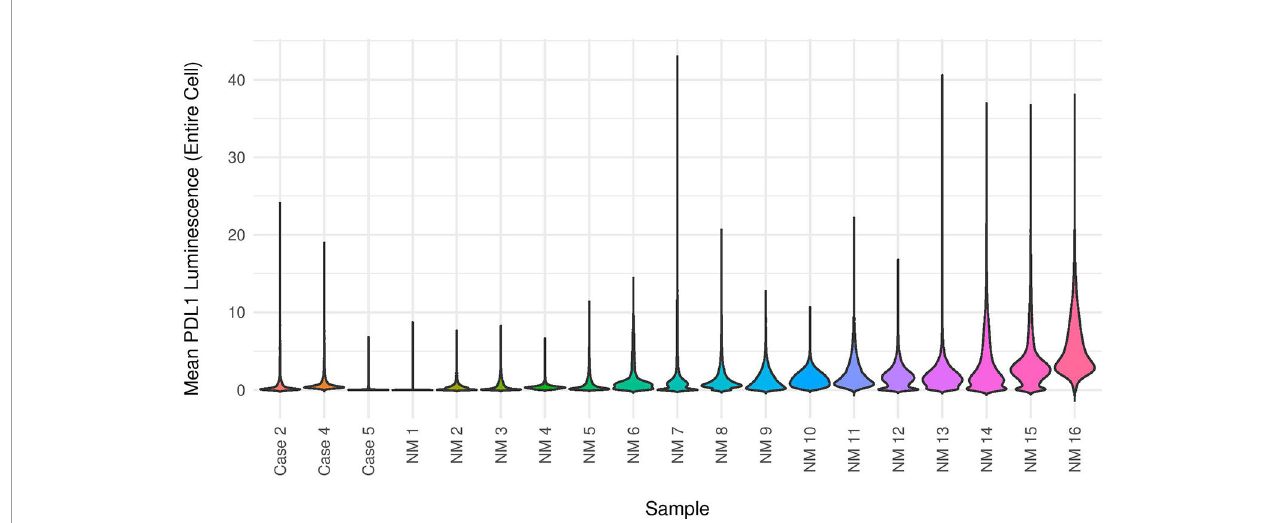
FIGURE 7 | PD-L1 mIF violin plot. Mean PD-L1 quantitative immuno fl uorescence in baseline biopsies for metaplastic Cases 2, 4, and 5 as well as non-metaplastic (cases identi fi ed as ‘ NM ’ ) TNBC from the same clinical trial in a violin plot. A trend towards lower mean PD-L1 expression is noted in the metaplastic